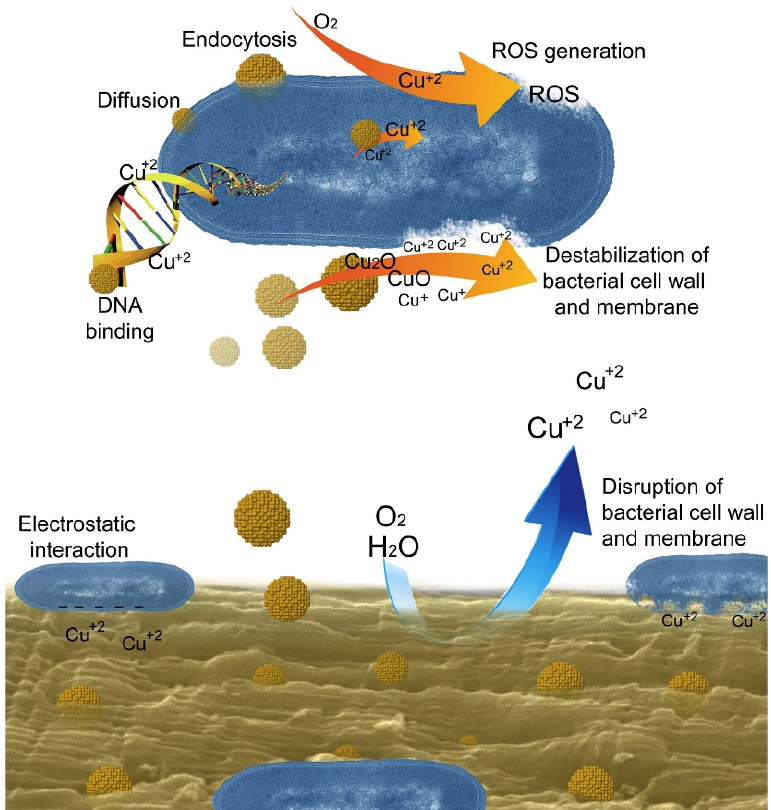
Figure 8. Mechanism of action against bacteria of copper nanoparticles (reproduced with copyright permission from Tamayo et al. [179]).